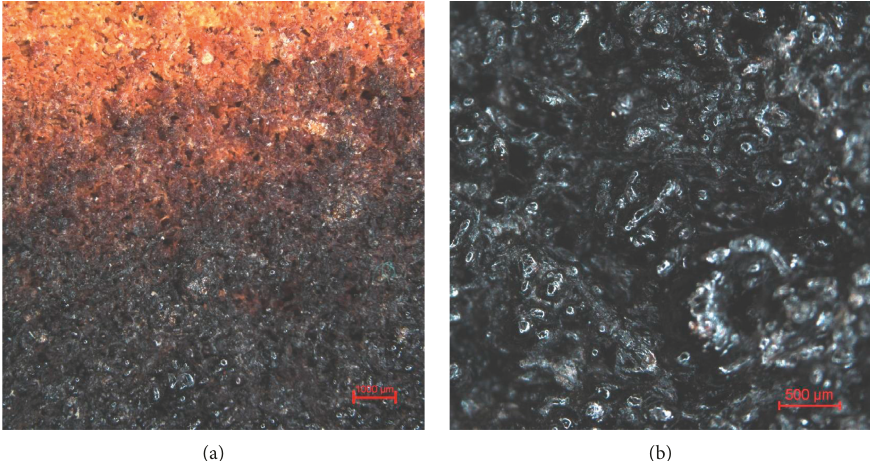
Figure 4: Microscopic observation of the surface of leather panels. (a) Border area with 10x magnification; (b) core heated area with 20x